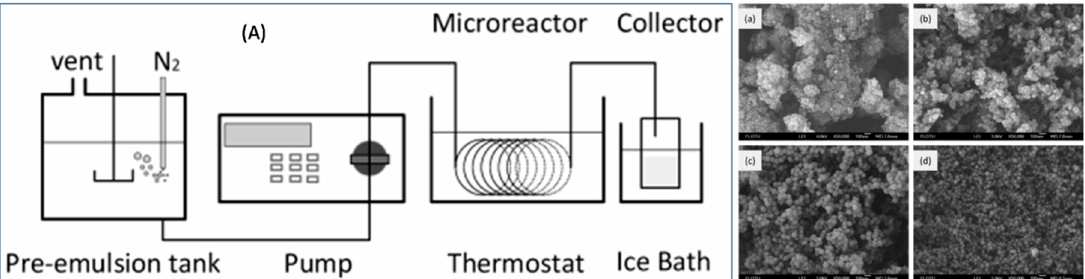
Figure 5. ( A ) Setup for continuous flow emulsion polymerization and SEM images of products obtained. ( a ) Emulsifer TX-100/SDBS, TX-100/SDBS concentration 6.812/8.515 nM, Pre-emulsion 20 min; ( b ) Emulsifier TX-100/SDBS, TX-100/SDBS concentration 6.812/34.06 nM, pre-emulsion 10 min; ( c ) Emulsifier TX-100/SDBS, TX-100/SDBS concentration 6.812/1.703 nM, pre-emulsion 20 min; ( d ) Emulsifier TX-100/SDBS, TX-100/SDBS concentration 27.25/6.812 nM, pre-emulsion 10 min.